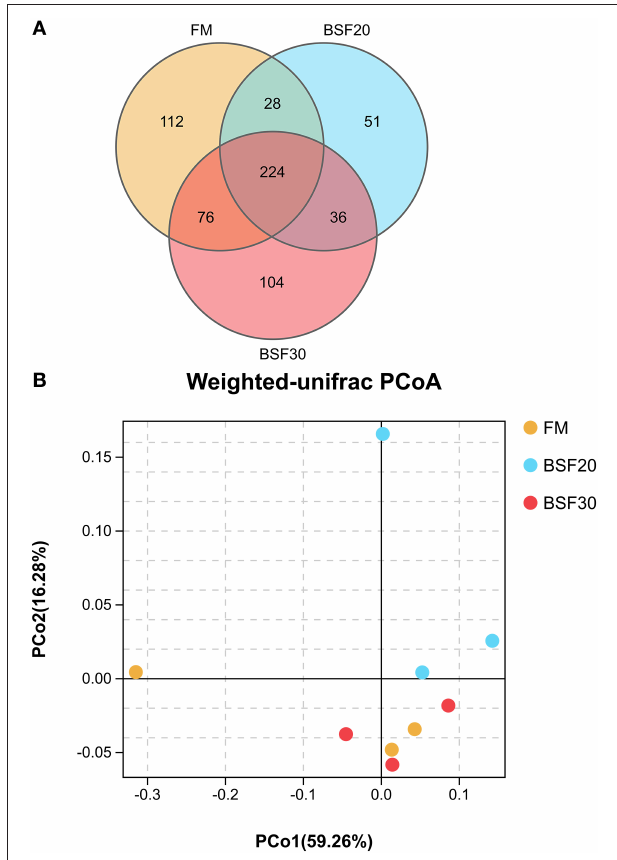
FIGURE 4 | Intestine microbiota responses of L. vannamei fed with diets containing different contents of BSF. (A) Venn diagrams of OTUs among groups; (B) Principal coordinates analysis (PCoA) based on weighted-UniFrac analysis of bacterial profiles.